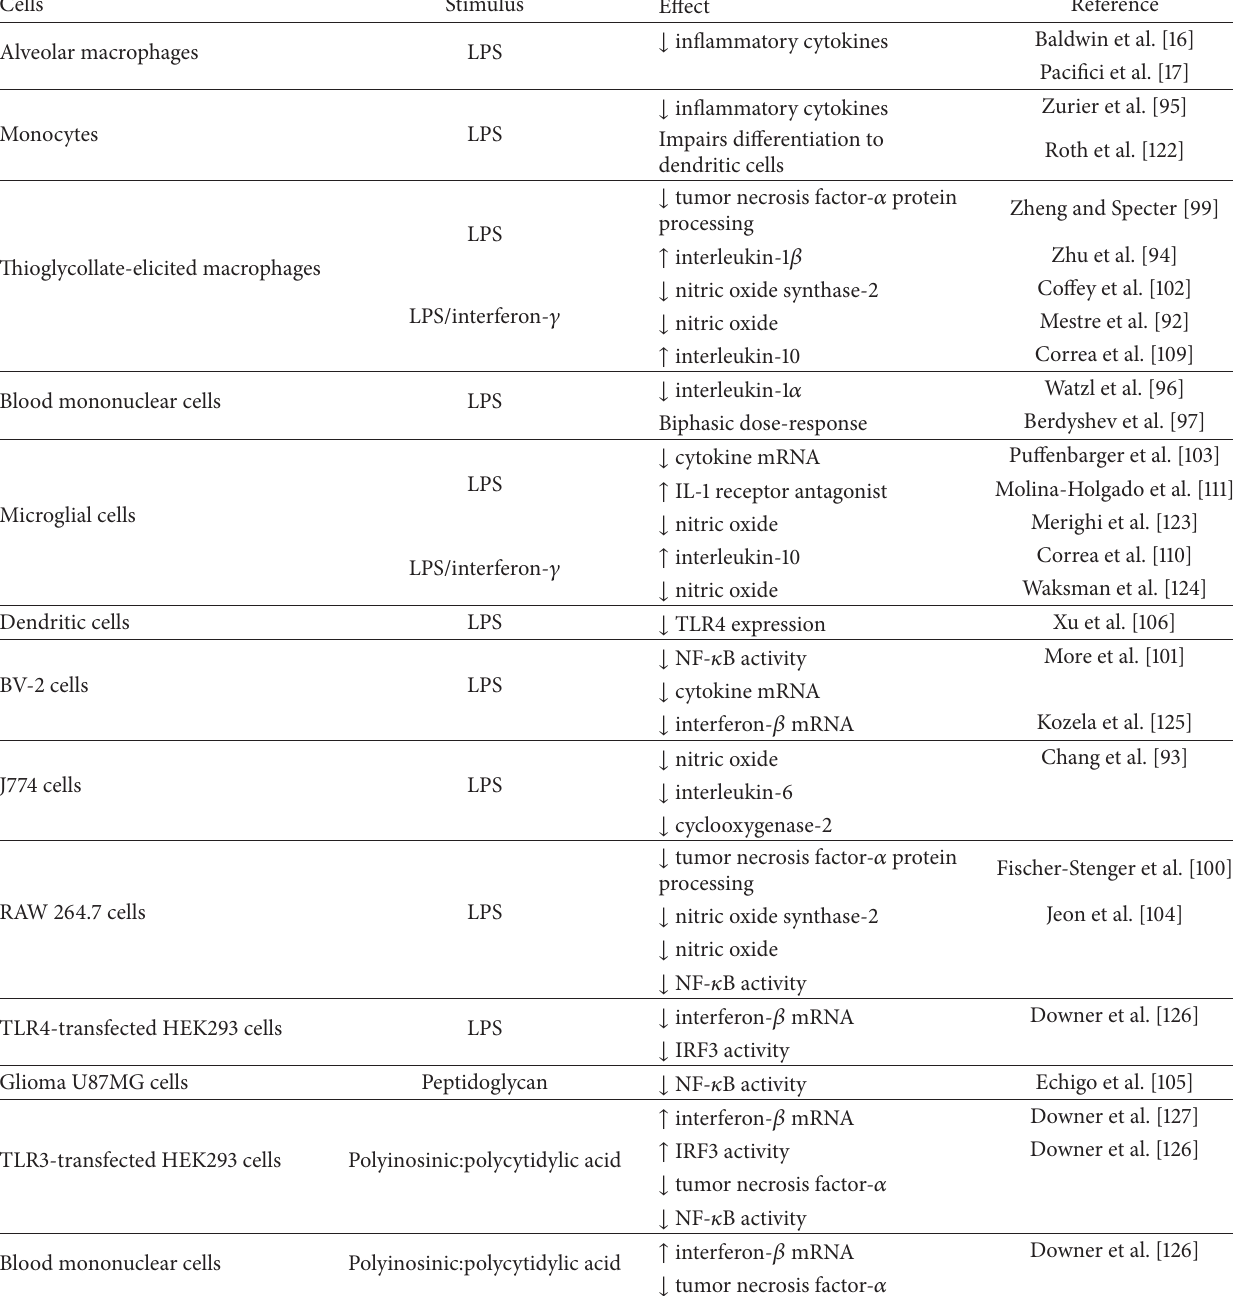
Table 1: Cannabinoid effects on in vitro TLR